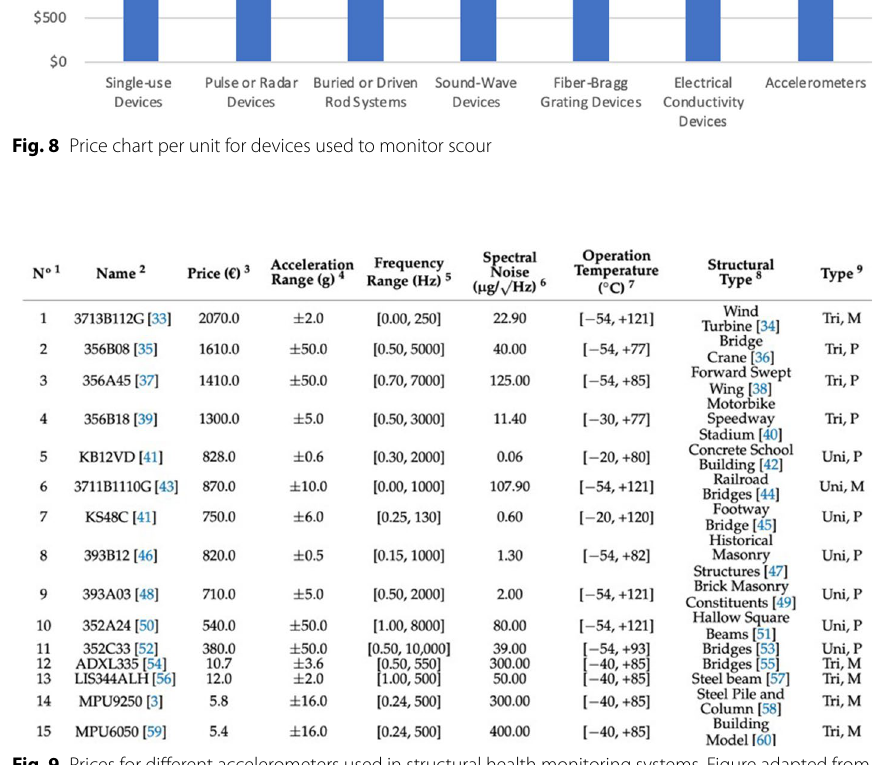
Fig. 9 Prices for different accelerometers used in structural health monitoring systems. Figure adapted from Reference (Komarizadehasl et al. 2021) with permission from